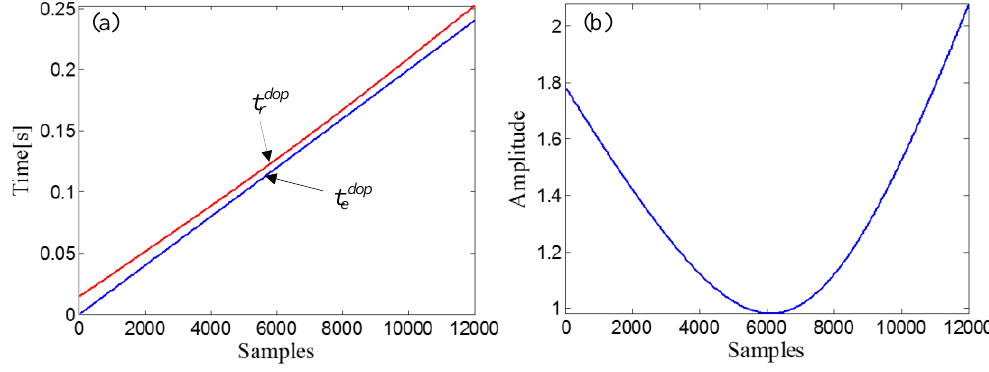
∪ [0.2:0.1:0.9]}. Figure 22a shows the maximal correlation coefficients for the different elements from set T . Figure 23. ( a ) Receive-time-vector (red curve) and the time vector of the source signal (blue curve) and ( b ) Curve of the demodulation weights, in the experimental case study of the bearing signal with the inner-race defect.